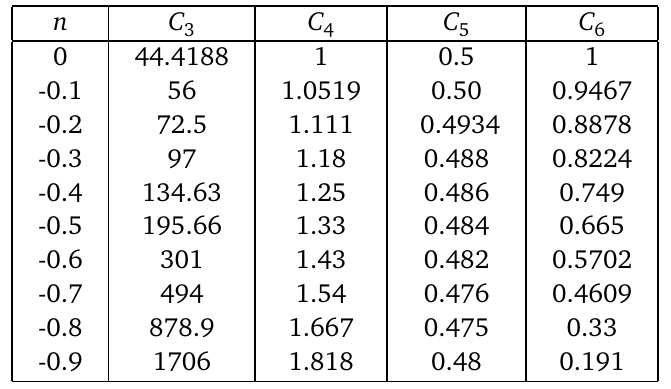
in Eq. (31) is 0 2